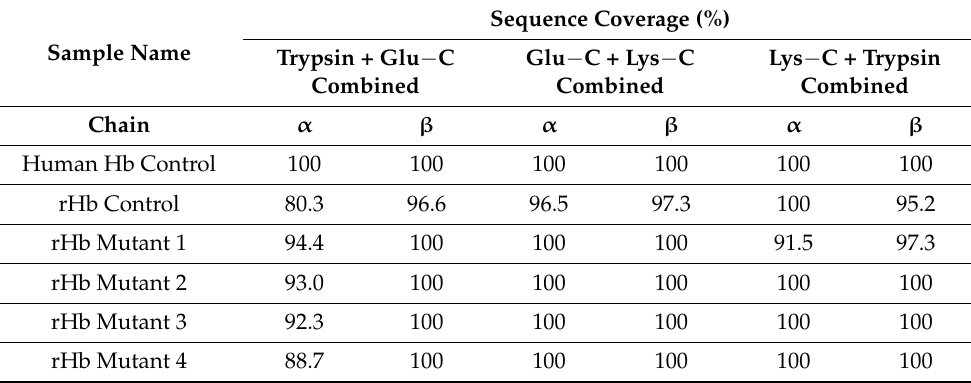
Table 3. Sequence coverage in rHbs with 10% acetonitrile treated Hbs digested with three different enzymes in combination in LC −